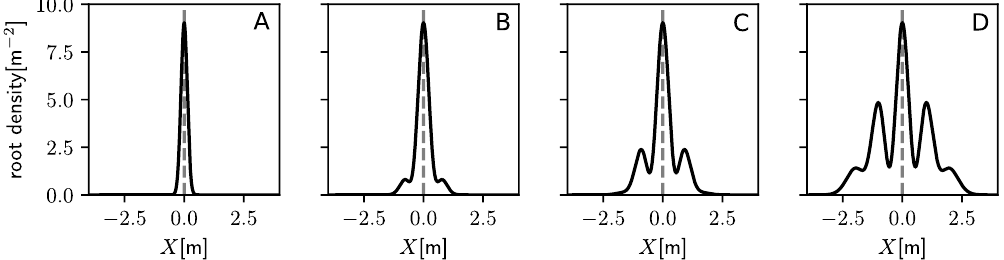
Figure 3. Root system growth as shoot biomass increases. A plot of the axisymmetric root kernel, G (see (A1) in Appendix A), as a function of the space coordinate X when ( A ) B ( X , T ) = 0, ( B ) B ( X , T ) = 0.2, ( C ) B ( X , T ) = 0.3, ( D ) B ( X , T ) = 0.4 = : K . The kernel is a Gaussian function multiplied by a polynomial factor, that mimics adventitious root branching observed in some plant species [50]. Parameters in (A1) and (A2): S 0 = 0.15m, c 0 = 1, c 2 = − 0.135, c 4 = 7.09 × 10 − 3 , c 6 = − 9.11 × 10 − 5 , c 8 = 3.84 × 10 − 7